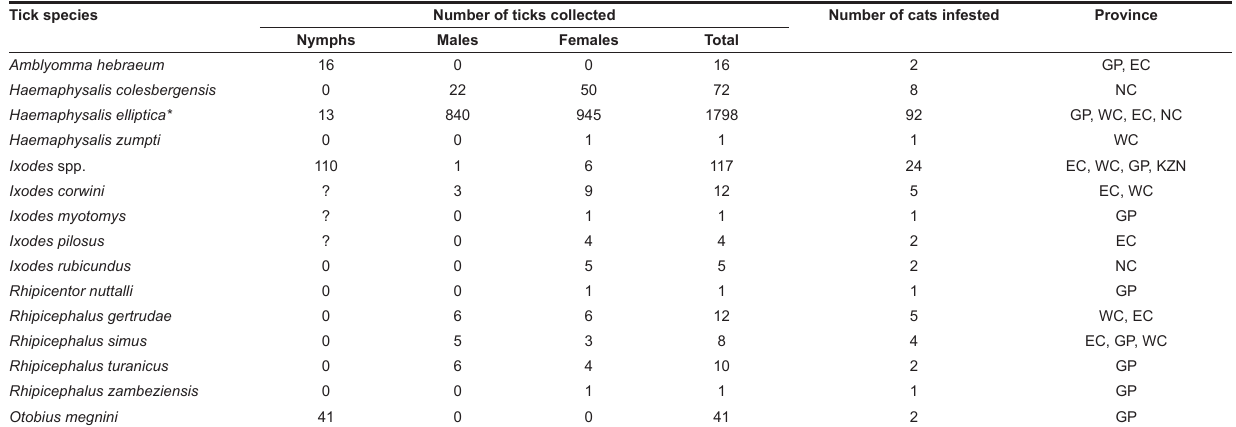
TABLE 1 Ticks collected from 130 domestic cats in five of South Africa’s nine provinces